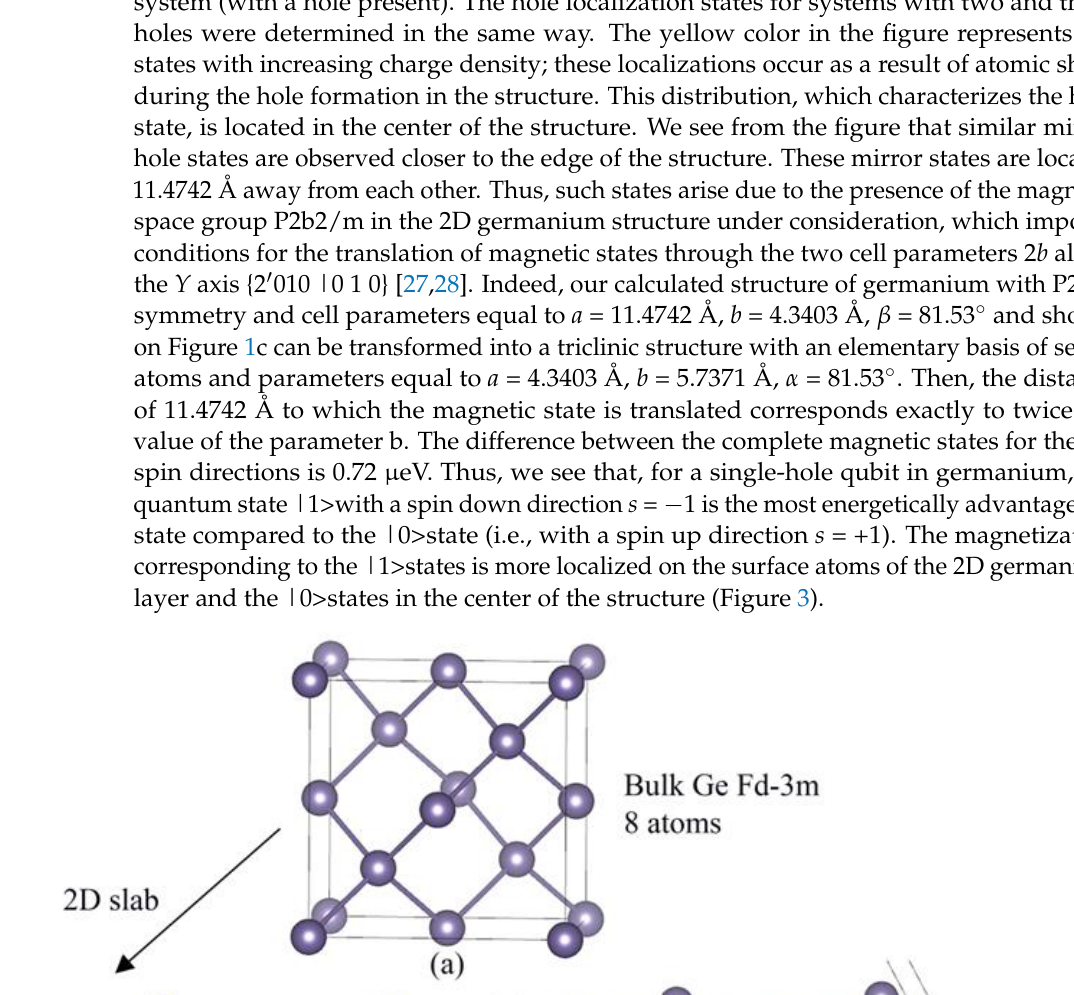
Nanomaterials 2022 , 12 , x FOR PEER REVIEW Figure 1. Structure of bulk germanium Fd-3m ( a ), original, unrelaxed structure of the 2D P2 1 /c layer with direction (105) cut from the bulk structure ( b ), relaxed structure of the 2D P2/m layer ( c ).